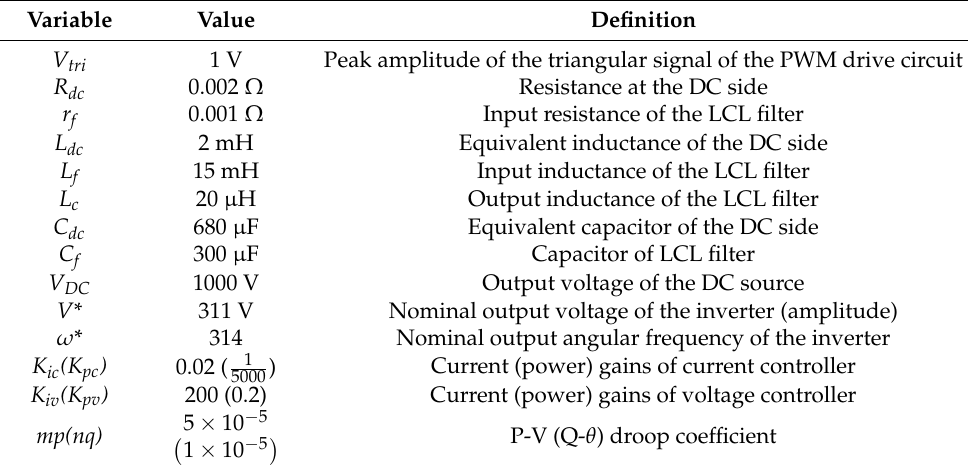
Table 2. Component parameters and their definitions of the